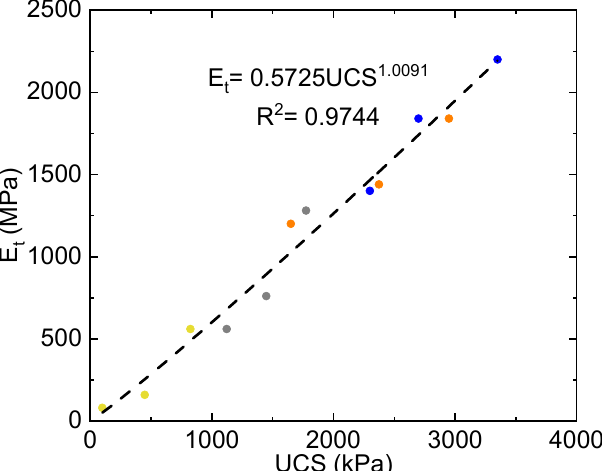
Figure 9. Relationship between E t and UCS for salinity study with samples tested at 7, 28, and 90 days: marker colors are 0 g/L (blue), 5 g/L (orange), 35 g/L (grey), and 100 g/L (yellow). Data [34].